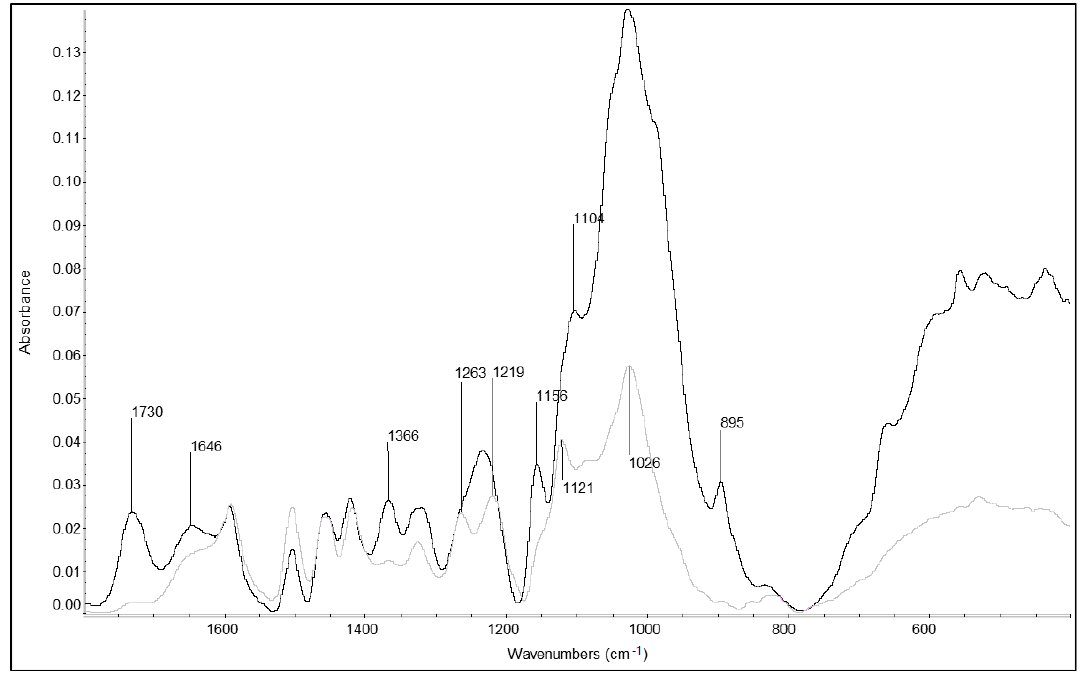
Figure 3. Fingerprint region (1800–400 cm − 1 ) of infrared spectra of contemporary (CE—black line) and air-dried archaeological elm (AE—grey line).